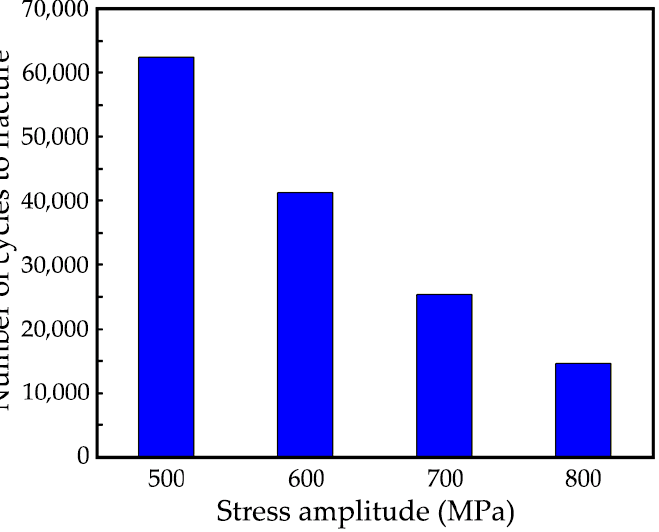
Figure 5. High cycle fatigue properties of welded TC4 alloy joints under different stress states.